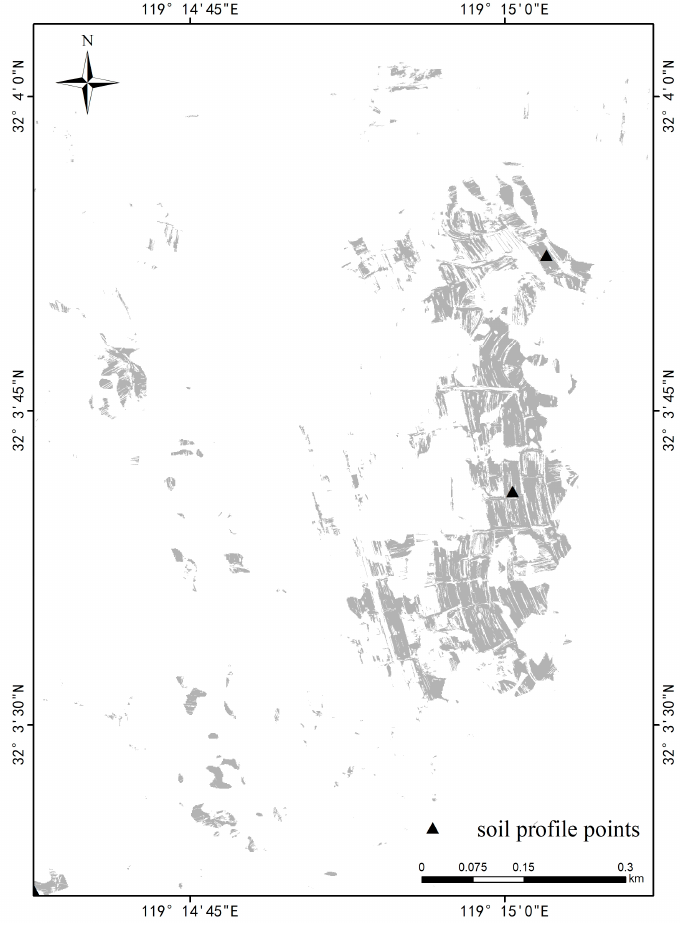
Figure 4. Section sample point diagram.